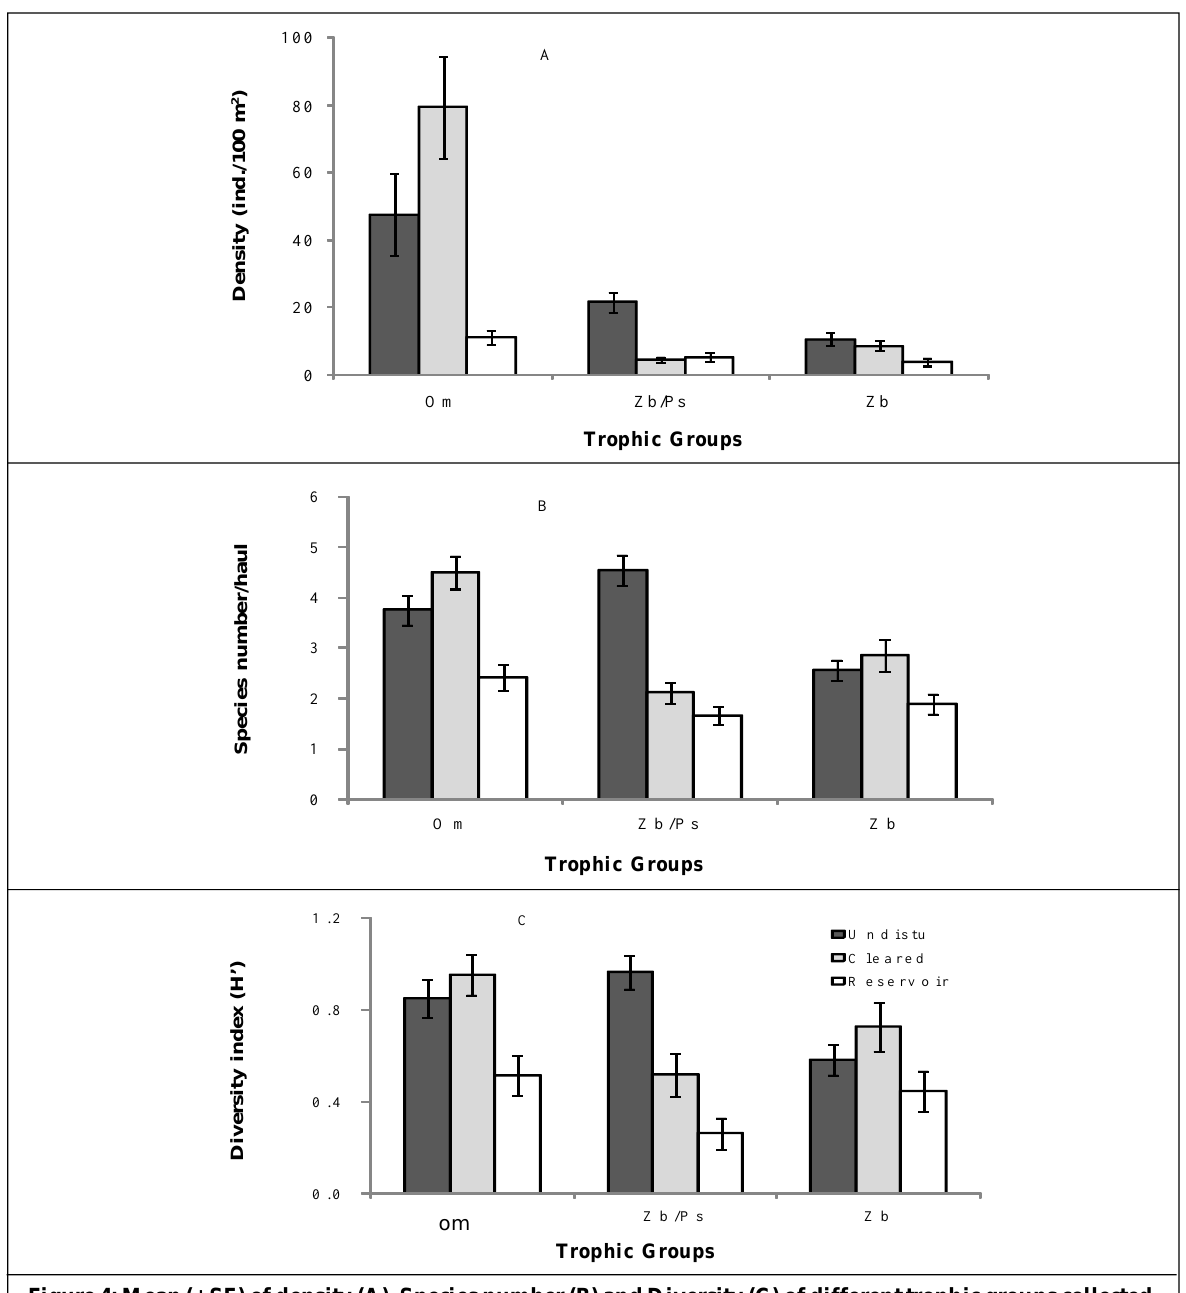
Figure 4: Mean (± SE) of density (A), Species number (B) and Diversity (C) of different trophic groups collected from undisturbed (black bars) cleared-only (grey bars) and reservoirs (white bars) in mangrove creeks along the coastline of